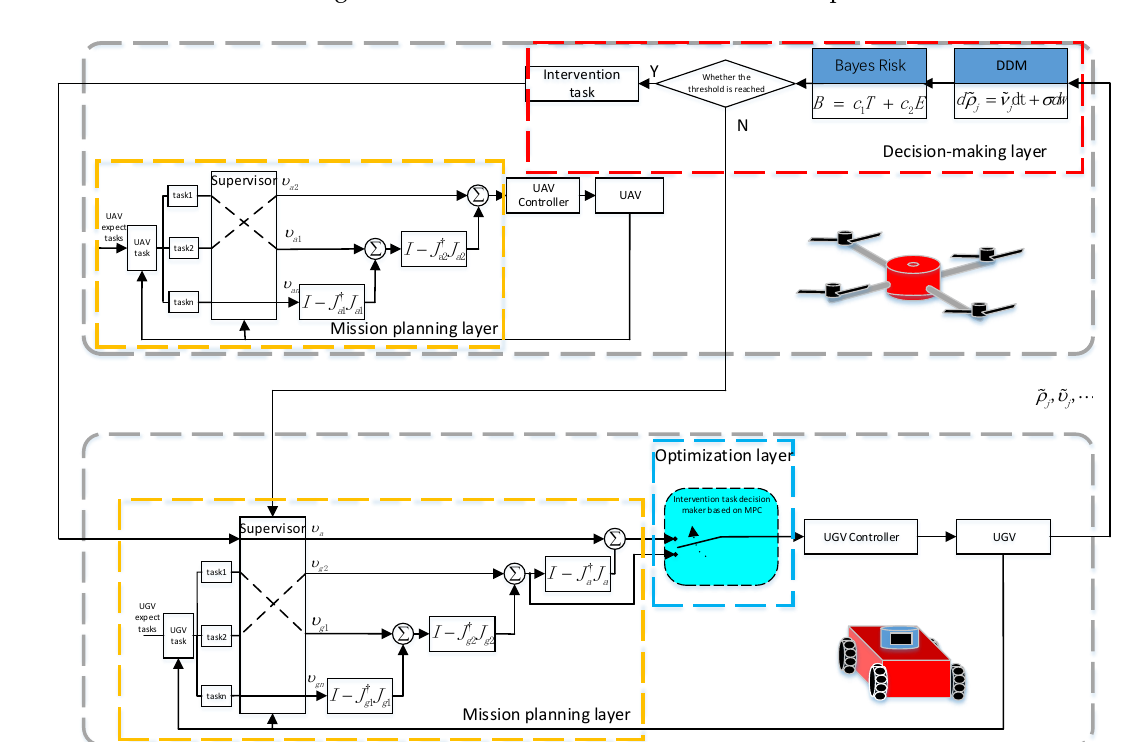
Figure 2. Framework design of air-ground cooperative system. It is mainly composed of three layers. (1) Task planning layer: is responsible for task design based on NSBC and resolution of task conflicts (2) Decision-making layer: is mainly responsible for judging the timing of intervention. (3) Optimization layer: optimizes the decision-acceptance problem for